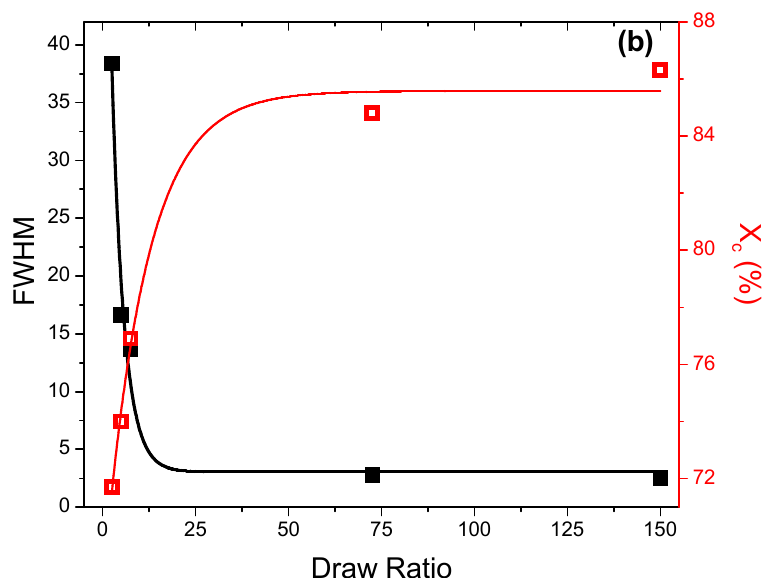
Figure 7. ( a ) Intensity as a function of azimuthal angle Ø for the (200) diffraction peak for the DR5, DR70, and DR150 samples. ( b ) The full-width at half maximum (FWHM) of the (200) reflection as obtained from the azimuthal profiles and the sample crystallinity is presented, including the DR2.5 and DR7.5 samples as a function of draw ratio. The lines (a) are Lorentzian fits and (b) guides for the eye only.